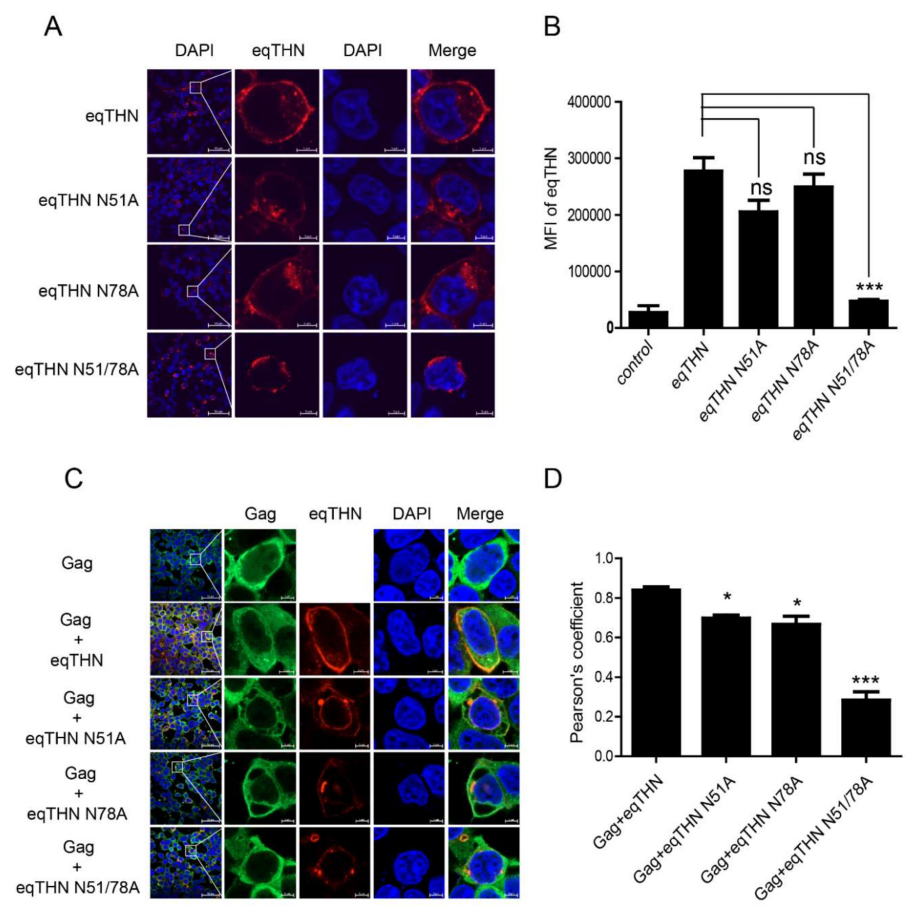
Figure 3. Destruction of N-glycosylation influences localization of eqTHN to the PM. ( A ) HEK293T cells transfected with 1 µ g of either WT eqTHN, eqTHN N51A, eqTHN N78A or eqTHN N51 / 78A were examined using confocal microscopy with surface staining and intracellular staining: blue, cell nucleus; red, eqTHN protein tagged with FLAG. ( B ) HEK293T cells transfected with 1 µ g of plasmids expressing either pCDNA-eqTHNe-FLAG or its N-glycosylation mutants, and 1 µ g of plasmid expressing pcDNA3.1-FLAG as a control. At 24 h posttransfection, the cells were harvested and the mean fluorescence intensity of eqTHN on the cell surface was analyzed by flow cytometry using an anti-FLAG antibody. Error bars indicate the SEM from three independent experiments. ( C ) HEK293T cells were transfected with 1 µ g of EIAV gag and 1 µ g of eqTHN variants, and were examined using confocal microscopy: blue, cell nucleus; red, eqTHN protein tagged with FLAG; green, EIAV Gag. Each experiment was performed three times, and a representative result is shown. ( D ) Pearson correlation coe ffi cient values for the colocalization of Gag and eqTHN at the PM. Error bars from three independent experiments. ***, p < 0.001; *, p < 0.05; ns, not